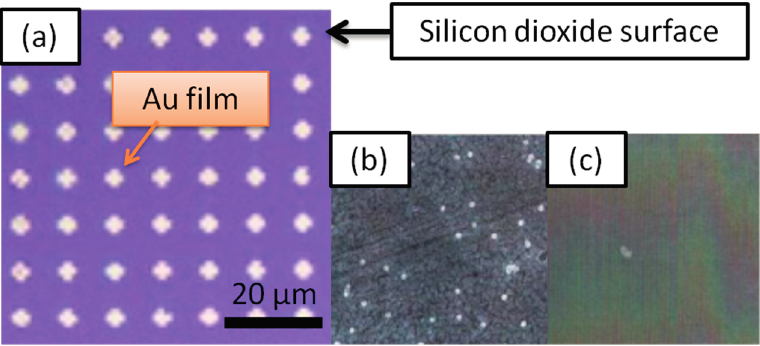
Figure 7. ( a ) Optical microscope image of 5 μ m × 5 μ m gold arrays produced on a silicon dioxide surface; ( b ) Scanning electron microscope image of 8 nm diameter thiolated superparamagnetic “target” beads immobilized via chemical affinity between the gold surface and sulfur attached to the 8 nm magnetic beads. In ( c ) SPBs were not immobilized onto SiO 2 regions. Adapted from [9].